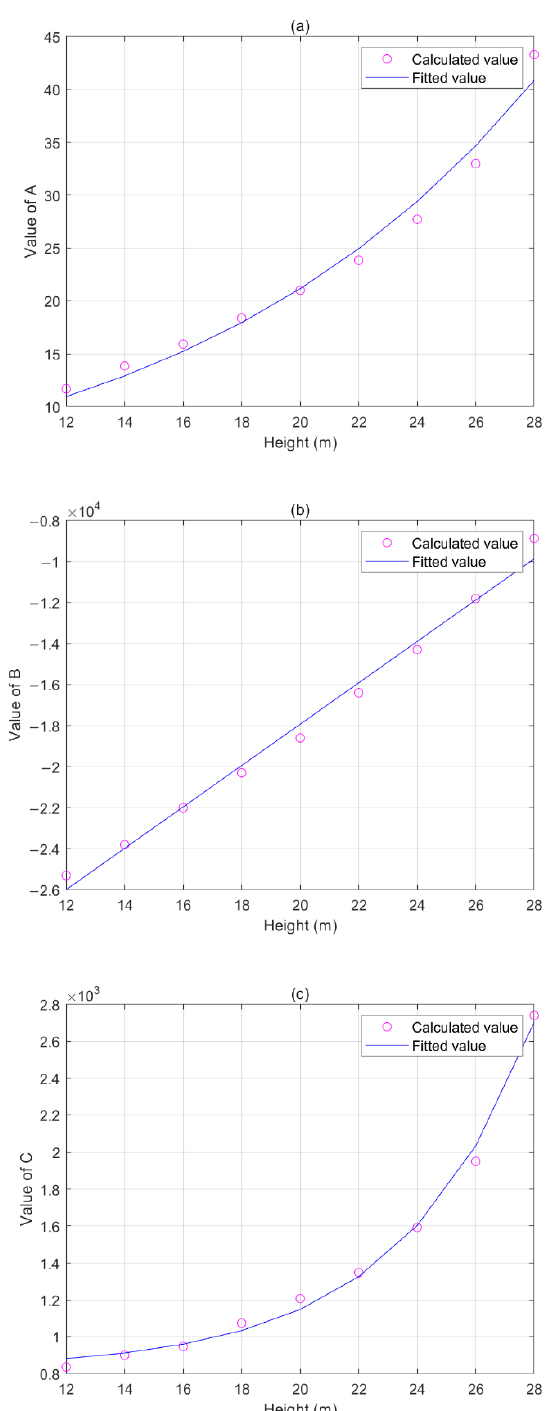
Figure 13. Effects of tower height on coefficients: ( a ) A of different tower heights; ( b ) B of different tower heights; ( c ) C of different tower heights.